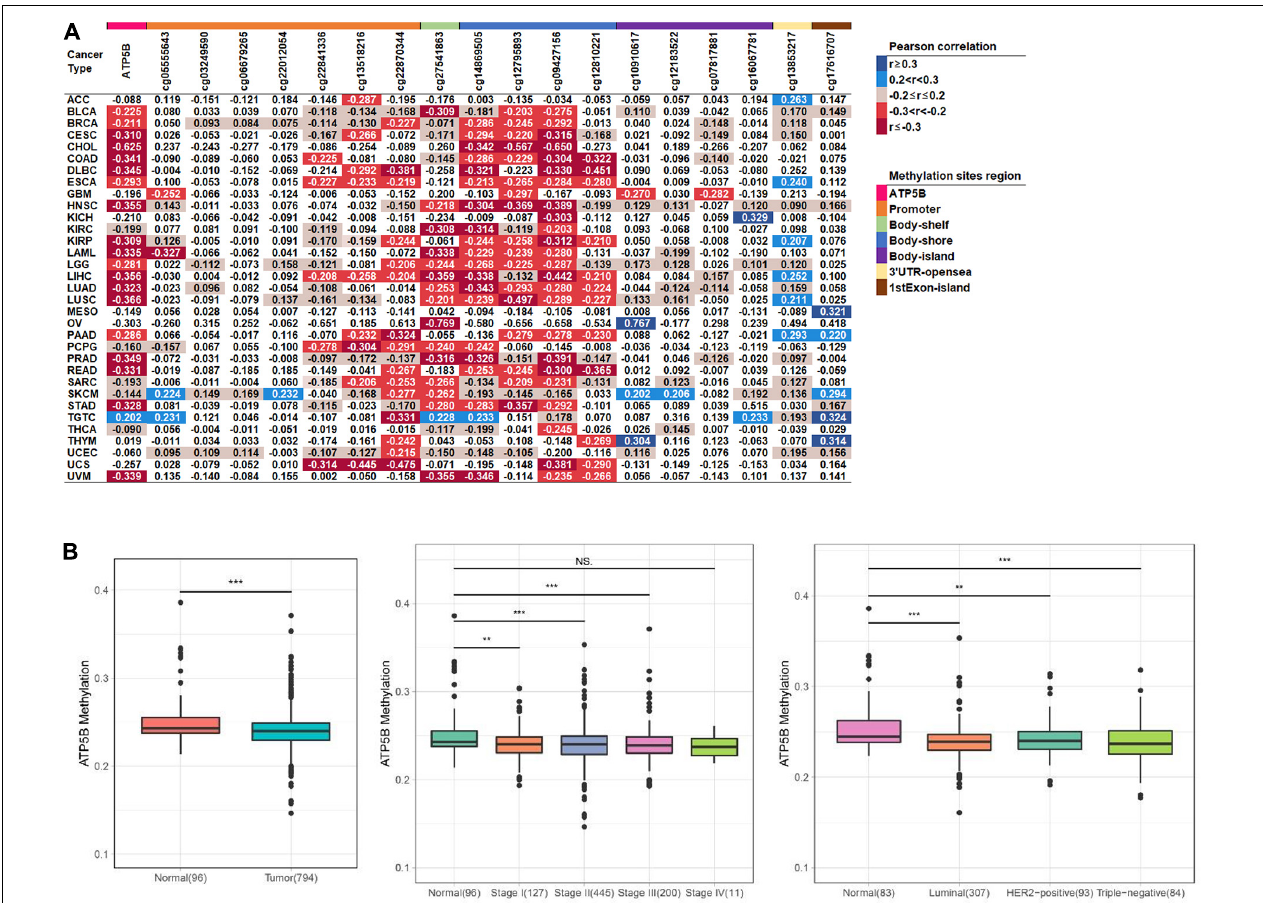
FIGURE 2 | The methylation level analysis of ATP5B in the TCGA datasets. (A) Correlation between methylation levels and mRNA expression of ATP5B and its 18 methylation sites across 33 TCGA cancer types. The number represents the Pearson correlation r -value, and all statistically significant r -values are graded and colored (right legend, p < 0.05). (B) The ATP5B methylation level in the TCGA breast cancer dataset compared with normal tissues, stages I–IV and the three molecular subtypes. Boxplots represent the median with the interquartile